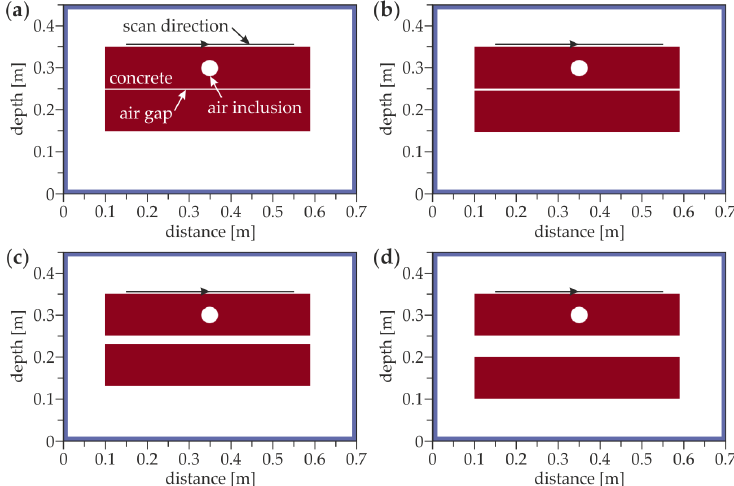
Figure 10. FDTD model of the concrete slabs with an air gap of the thicknesses ( a ) 1 mm (model #2.1); ( b ) 4 mm (model #2.2); ( c ) 20 mm (model #2.3); and ( d ) 50 mm (model